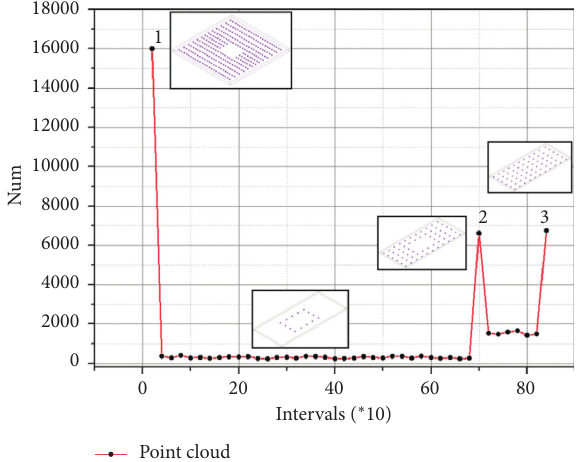
Figure 4: Interval density of the Z-axis stacking direction of point